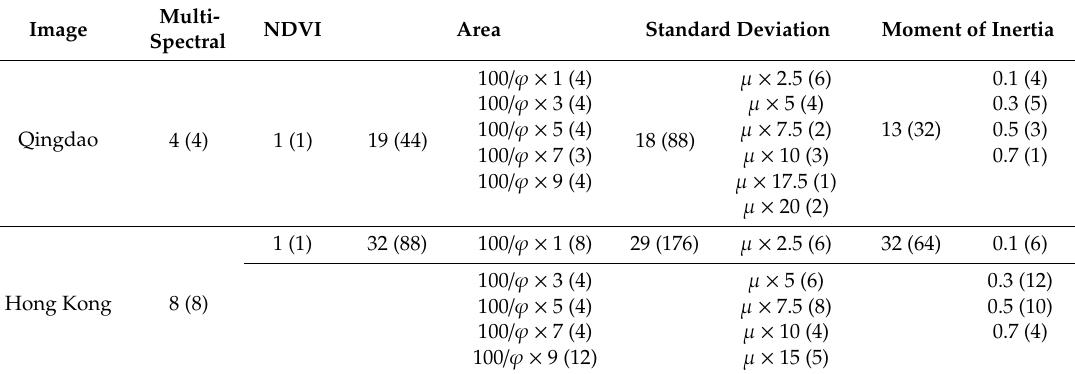
Table 3. Results of feature